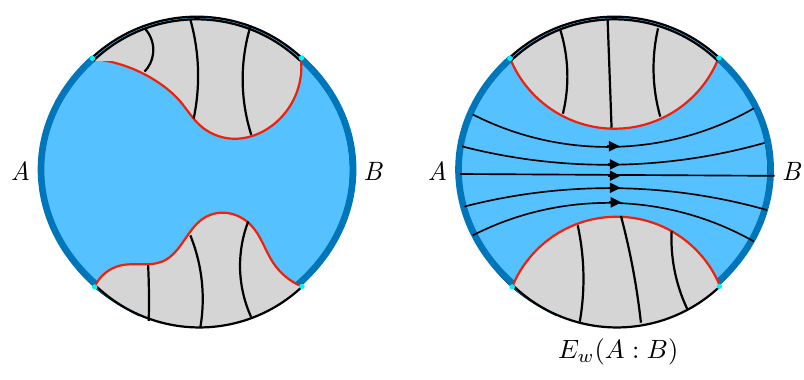
Figure 5 . Left: The (cid:13)ow x (cid:22) acts to change the geometry v (cid:22) can probe. Right: On the reduced manifold the maximum (cid:13)ux of v (cid:22) gives the holographic